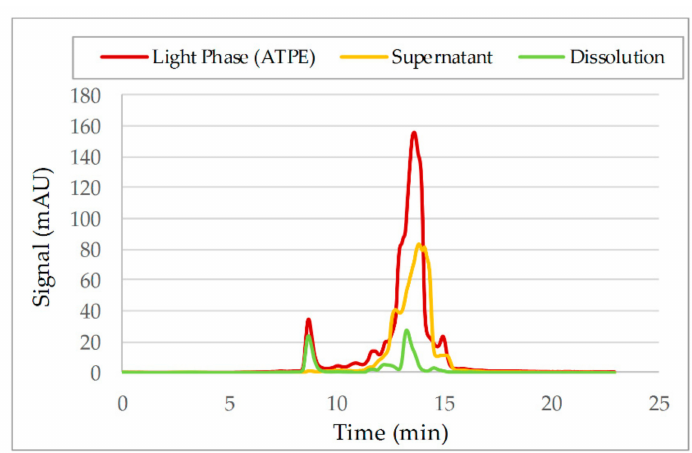
Figure 16. Recovery of mAb after precipitation. Precipitation was conducted, with LP (light phase) from ATPE (aqueous two-phase extraction) used as the base material and the absence of a washing